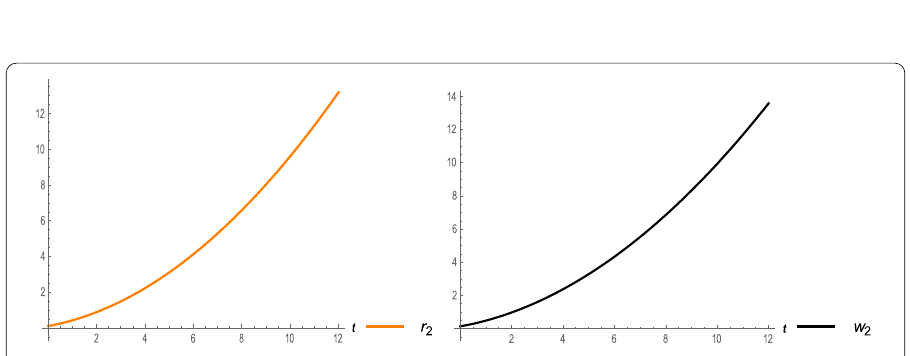
Figure 4 Two-dimensional surfaces of removed people (recovered or died people) and reservoir (the seafood area) of system (10)